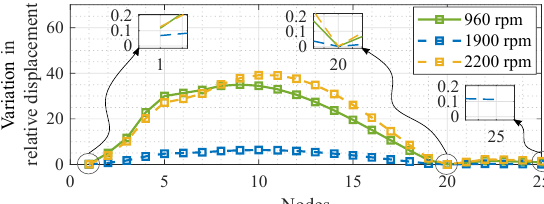
Figure 8. Location prediction accuracy test at three different speeds for induced unbalance at node